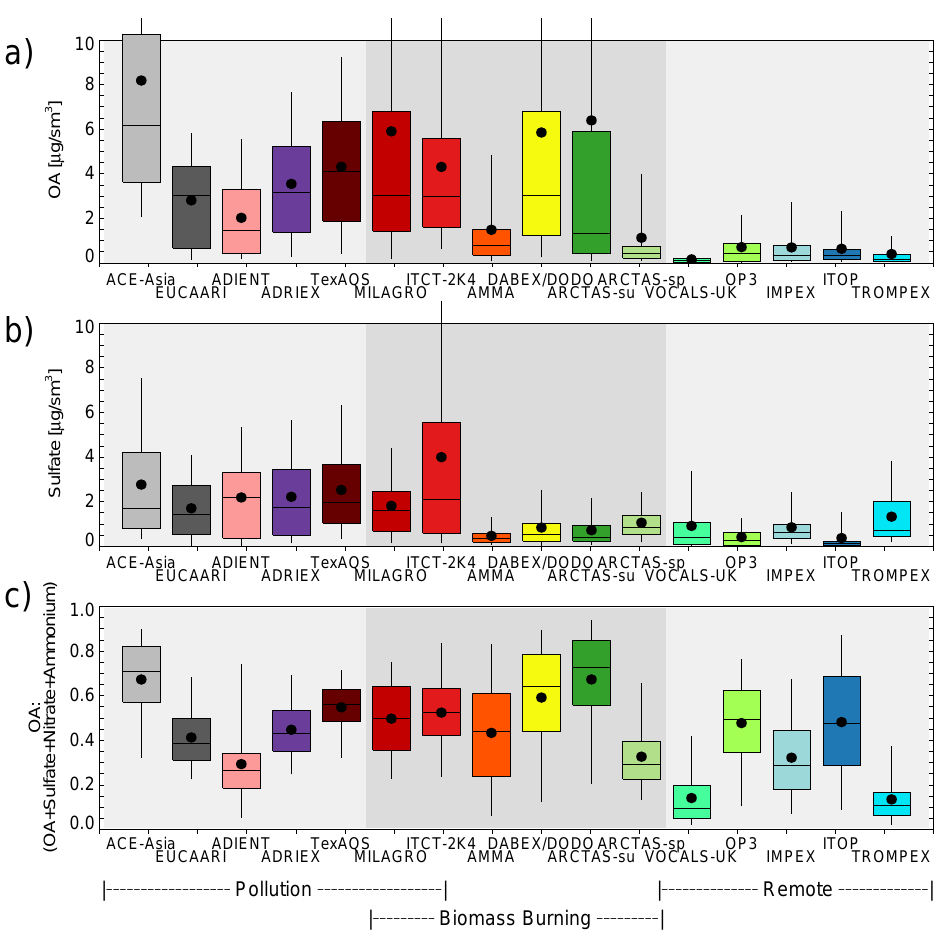
Fig. 2. Box and whisker plots of (a) the observed OA concentrations, (b) the observed sulfate concentrations and (c) the observed fraction of non-refractory fine aerosol (OA+sulfate+nitrate+ammonium) that is made up of OA for each field campaign. Campaigns are grouped in 3 types, labeled across the bottom. Means of the 1-min averaged data are shown as a solid dot, median as a horizontal line. The boxes denote 25th and 75th percentile, whiskers denote 5th and 95th